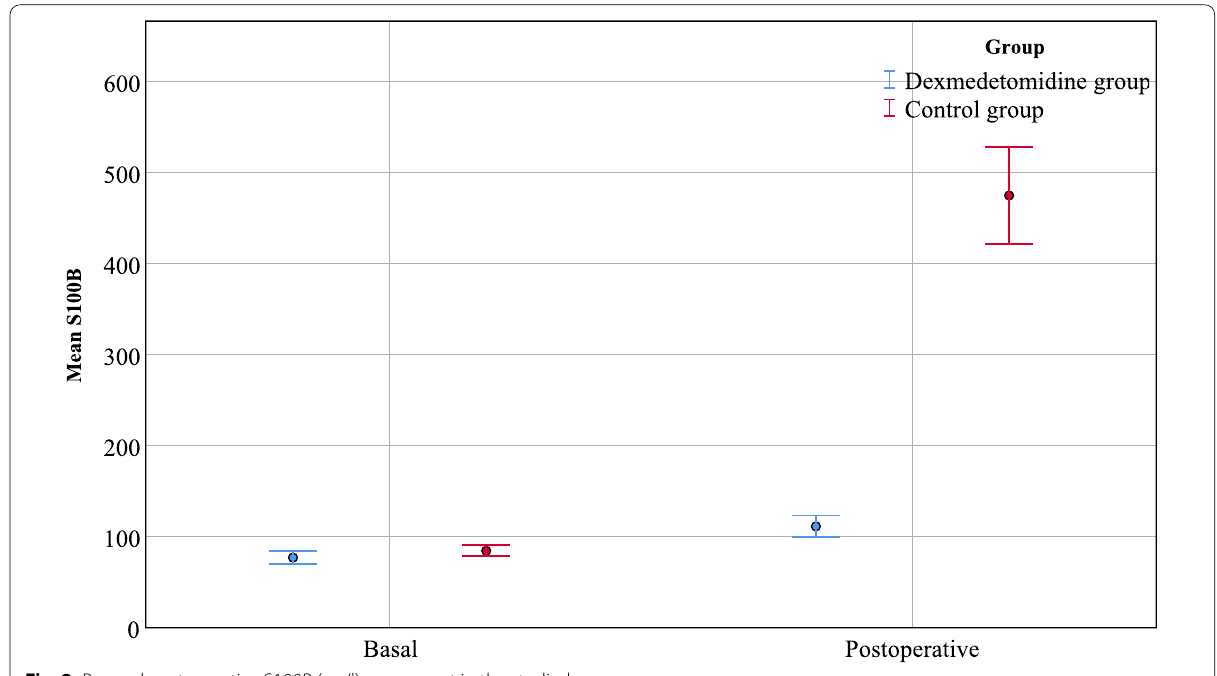
PCPT parameters showed no significant difference between the two groups at baseline. However, correct detection, correct reaction time, and omission error showed a significant improvement with Dex administra-